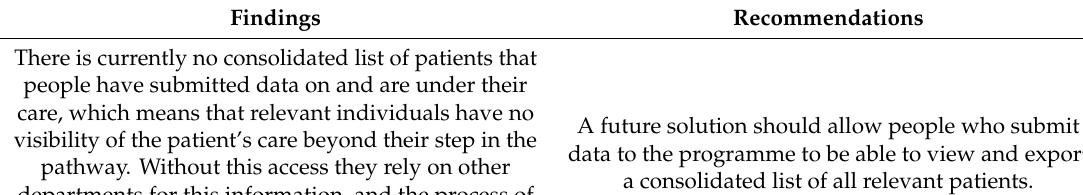
Table 2. Key findings, pain points and recommendations from